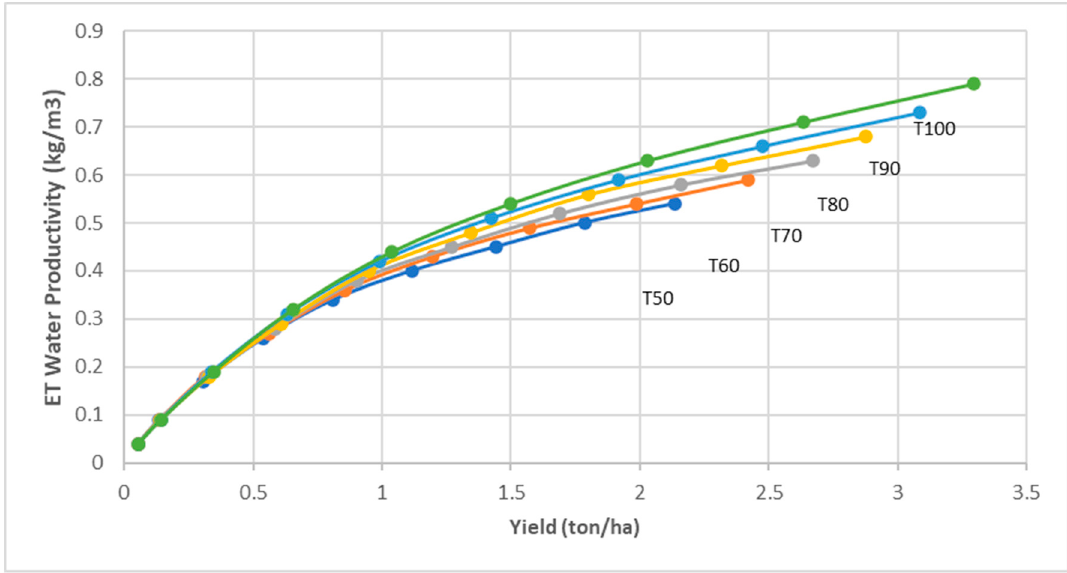
Figure 7. The productivity coefficient versus crop yield for the barley crop.